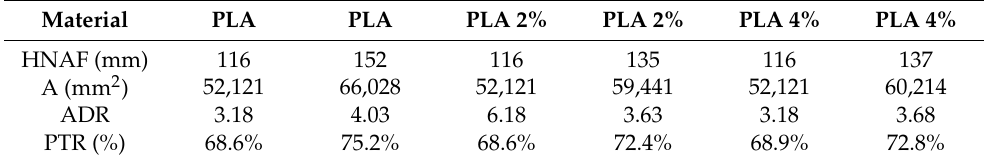
Table 3. Area of thermoformed shapes (A), aerial draw ratio (ADR) and percentage thickness reduc- tion (PTR) for the specimens transformed using different PLA-based materials and different